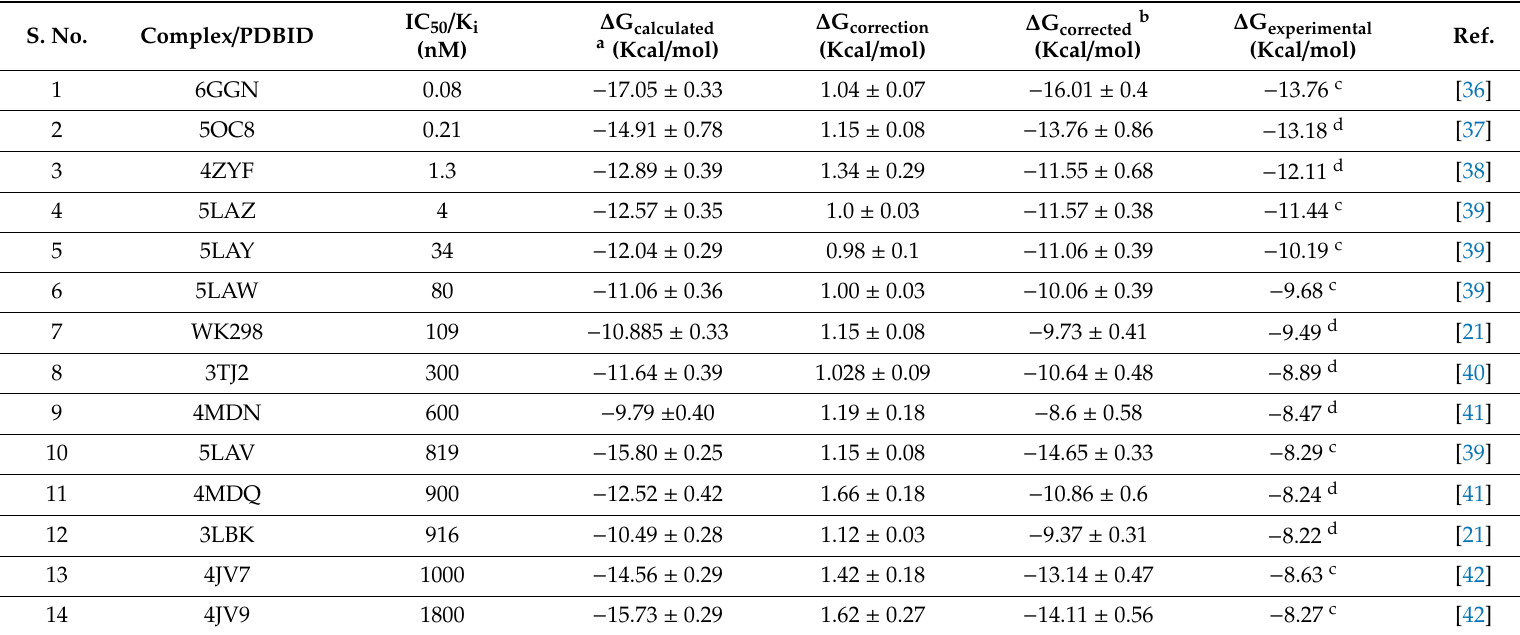
Table 2. FEP based binding free energy calculations for p53-MDM2